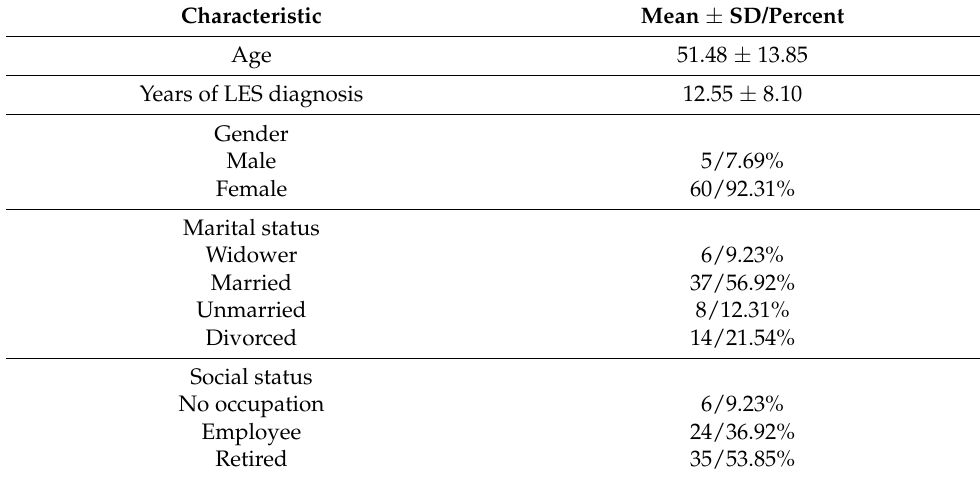
Table 2. Patient’s characteristic (n =